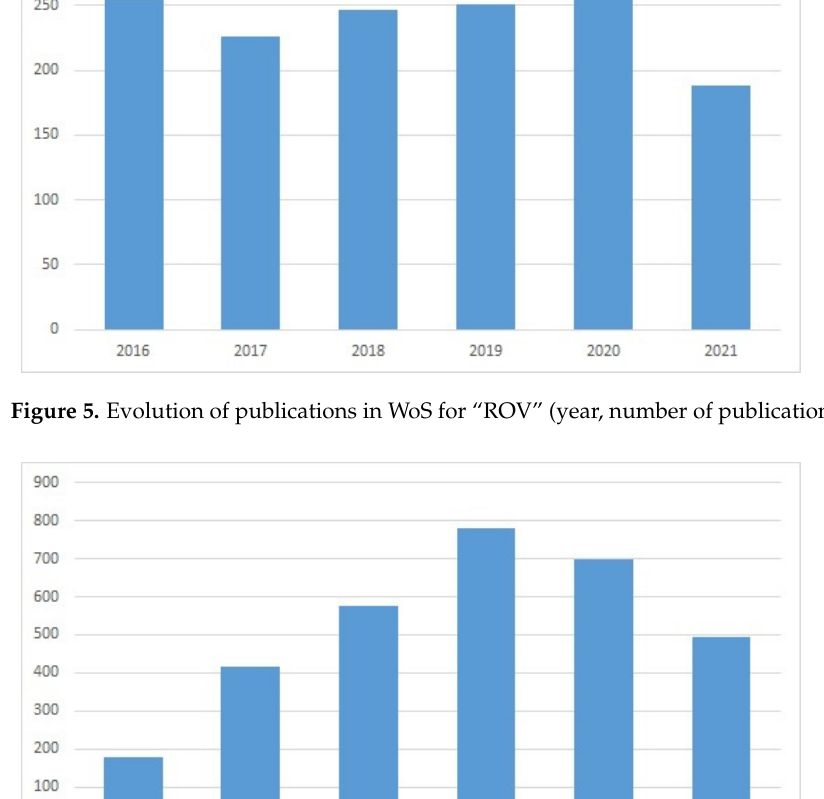
Figure 6. Evolution of publications in WoS for “remotely operated vehicle” AND “design” (year, number of publications).